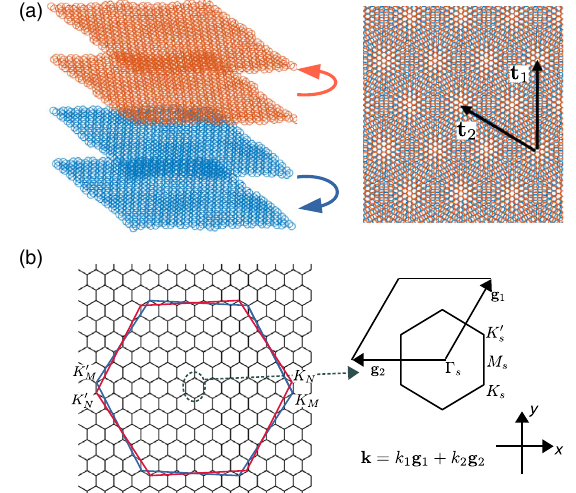
FIG. 1. (a) Left: Structure of the twisted multilayer graphene with M ¼ 2 and N ¼ 2 (see text). Right: Moir´e pattern of the twisted multilayer graphene, seen from the top. t 1 and t 2 denote the lattice vectors of the moir´e supercell. (b) The Brillouin zones of the top N multiplayers, bottom M multilayers, and the moir´e supercell are plotted in red, blue, and black lines,